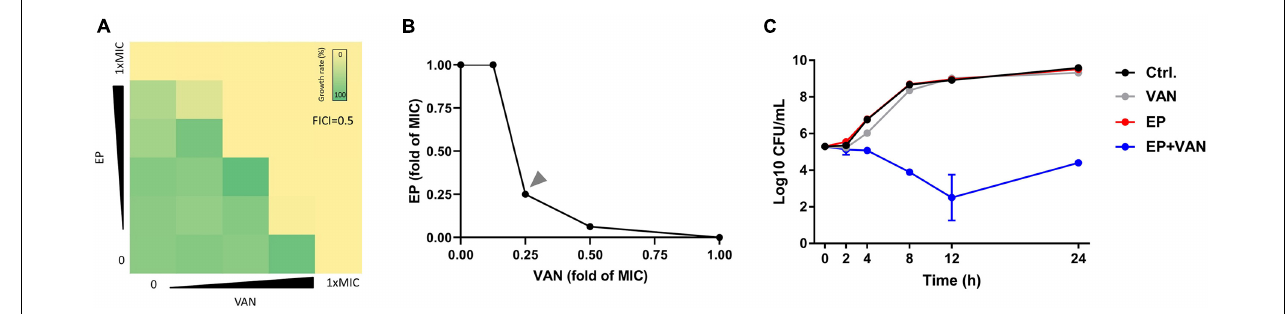
FIGURE 5 | Synergistic antimicrobial activity between EP and vancomycin. (A) The synergistic antimicrobial efficacy between EP and VAN by checkerboard dilution assay. FICI, fractional inhibitory concentration index. (B) Quantification of panel (A) by calculating the fold change of MIC. (C) S. aureus killing kinetics of sub-MIC of